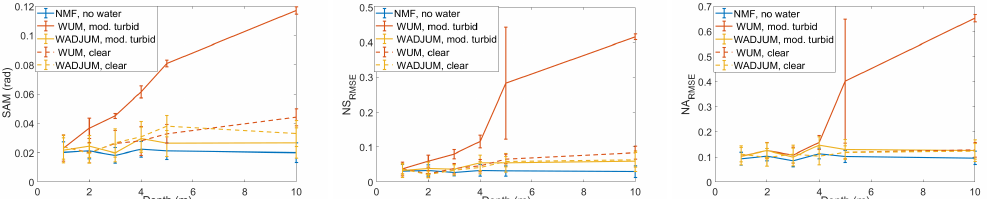
Figure 3. Spectral angle mapper, mean normalized RMSE errors on estimated spectra and estimated abundances using unmixing methods for various cases: when no water column is present ( NMF , no water), when the water column is present but the adjacency effects induced by the seabed and the water column are ignored ( WUM ), and when the water column and the adjacency effects are accounted for ( WADJUM ), for clear and moderately turbid water conditions. K 1 , K 2 and δ are